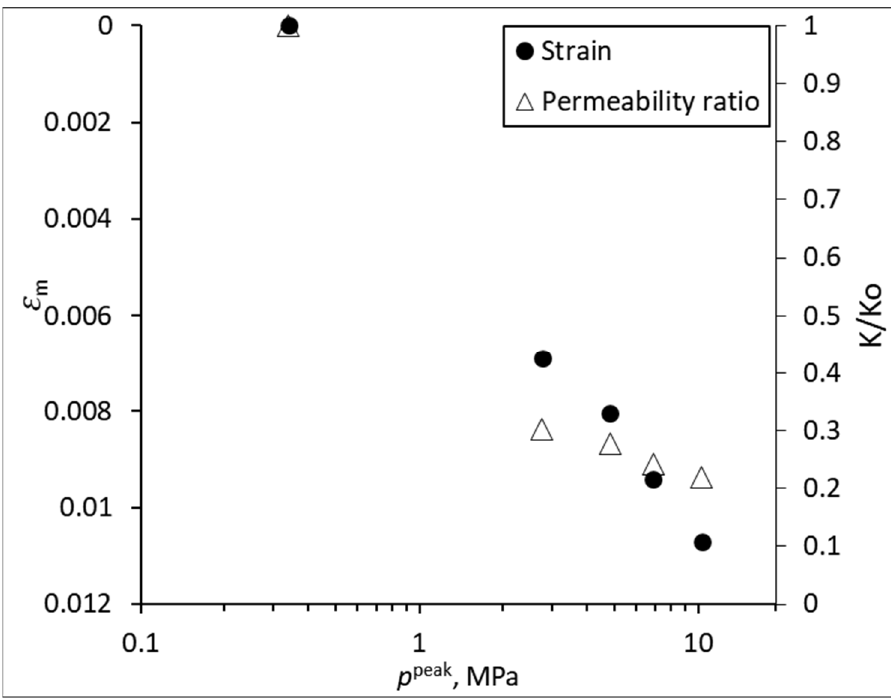
Figure 9. Unrecoverable strain and permeability developing with peak stress (coal sample 4).